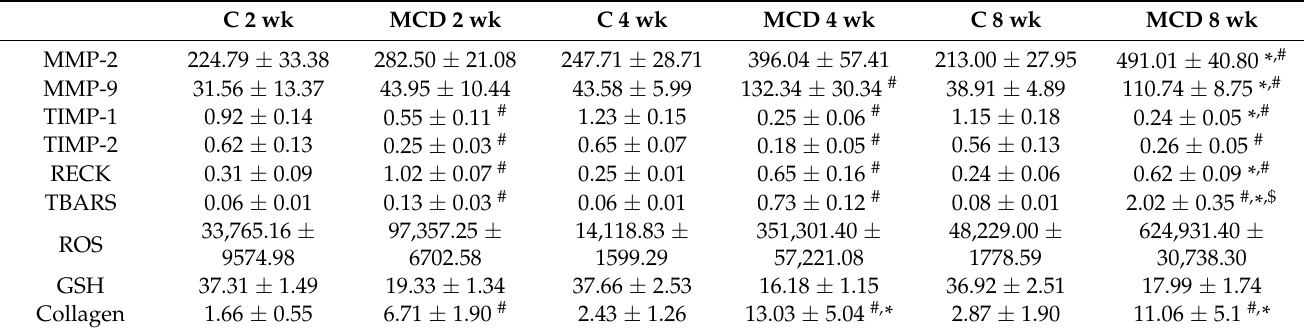
Table 2. Changes in liver MMPs, TIMPs, RECK, TBARS, ROS, GSH and collagen in rats fed with MCD diet.